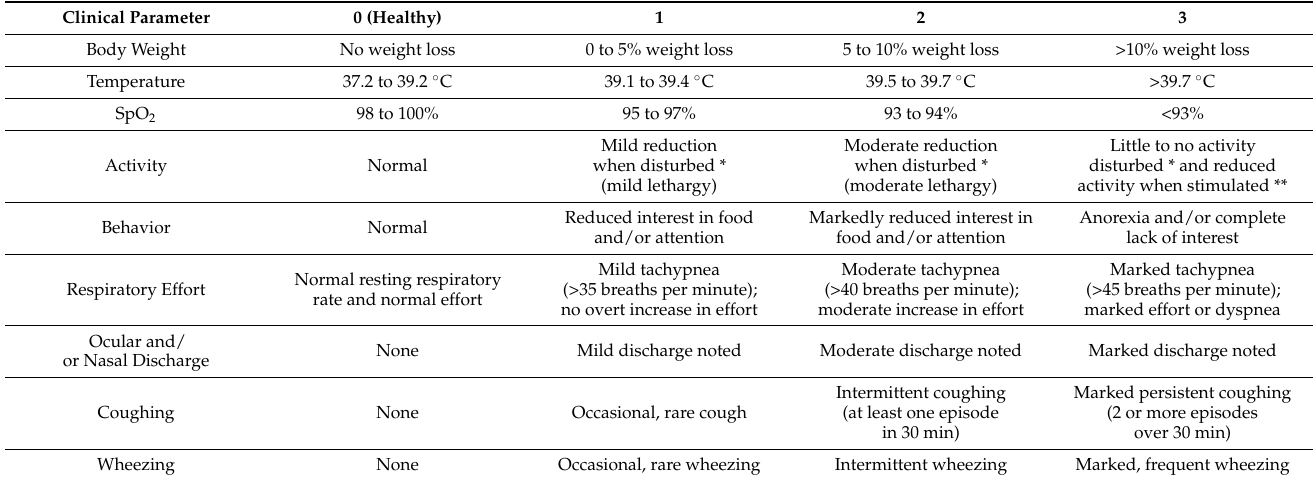
Table 1. Clinical Scoring System for Feline Respiratory Disease, adapted from